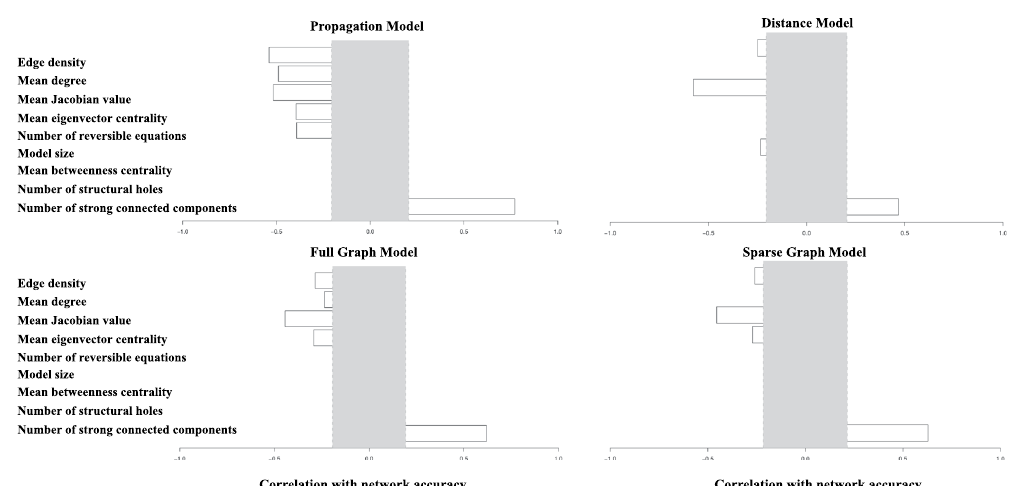
Figure 6. Correlation between properties (names on the left) and the propagation, distance and enhancement models (full graph model and sparse graph model) accuracies across 87 BioModels. Grey areas are the random expectations.